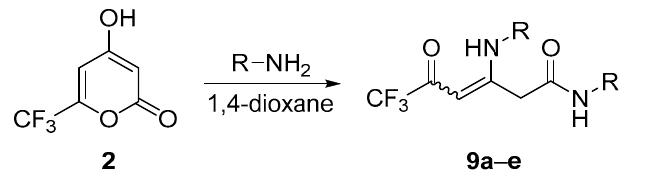
Table 5. The scope of reaction of TAL- f 3 with primary amines a . Enaminone